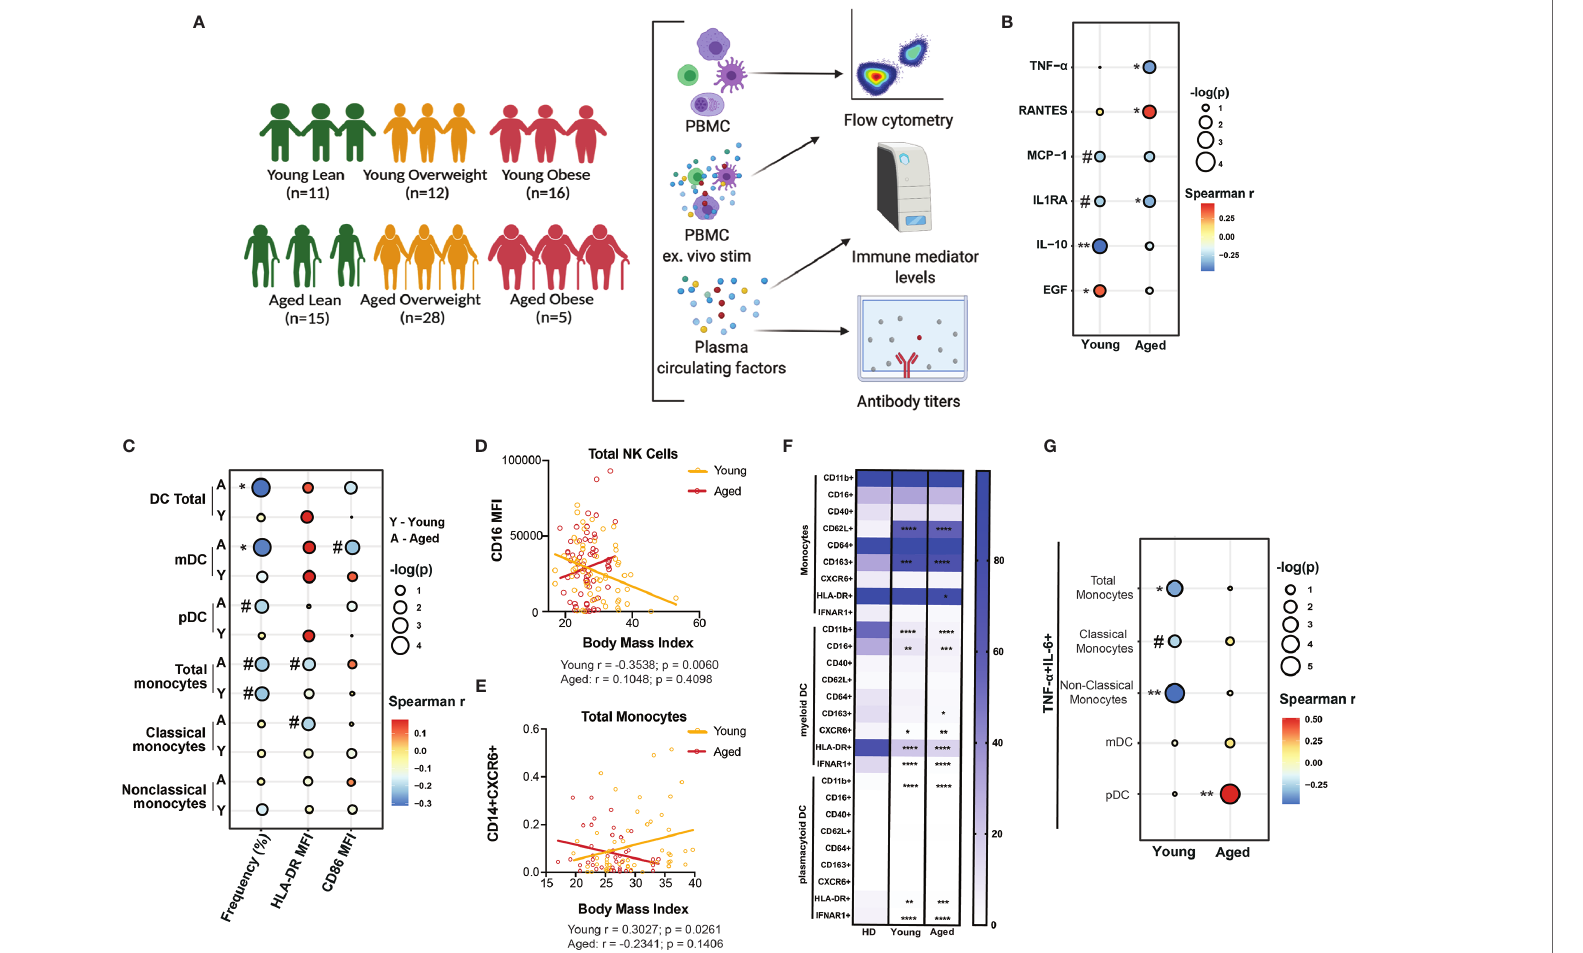
FIGURE 1 | Body mass index (BMI)-dependent aberrations in soluble immune mediators and innate immunity in young and aged COVID-19 patients. (A) Experimental design for the study. Blood was collected from 39 young (Lean=11, Overweight=12 and Obese=16) (<60 years of age) and 48 aged (Lean=11, Overweight=28 and Obese=5) hospitalized COVID-19 patients (>60 years of age). Immune phenotypes of PBMC and concentration of soluble immune mediators in plasma were determined by fl ow cytometry and Luminex, respectively. Serological responses to SARS-CoV-2 were measured by ELISA. A subset of PBMC were ex vivo stimulated with anti-CD3/CD28 dynabeads or bacterial agonist cocktail (Pam3CSK4, LPS, and FSL-I) to measure T cells and monocytes cytokine secretion, respectively, by fl ow cytometry. (B) Linear regression analysis of the concentration (pg/mL) of soluble immune mediators (cytokines, chemokines, and growth factors) that showed a signi fi cant or a trend of positive or negative correlation with BMI in both young and aged patients. (C) Linear regression analysis of the frequency of dendritic cell (DC) and monocyte subsets, expression of MHC class II molecule HLA-DR, and co-stimulatory molecule, CD86 with patient BMI in young and aged hospitalized COVID-19 patients. (D) Linear regression analysis of the expression of CD16 (Fc g RIII) on total CD56+ Natural killer (NK) cells with patient BMI in young and aged groups. (E) Linear regression analysis of the frequency of CD14+CXCR6+ monocytes with patient BMI in young and aged groups. (F) Differences in the phenotype of monocytes and DC subsets from young and aged COVID-19 patients compared to healthy donors. (G) Linear regression analysis of the dual expression of pro-in fl ammatory cytokines (IL-6 and TNF- a ) by monocytes and DC subsets in response to 8-hr ex vivo stimulation with bacterial agonists (Pam3CSK4, LPS, and FSL-I) with patient BMI. #p < 0.12, *p < 0.05, **p < 0.01, ***p < 001 and ****p <